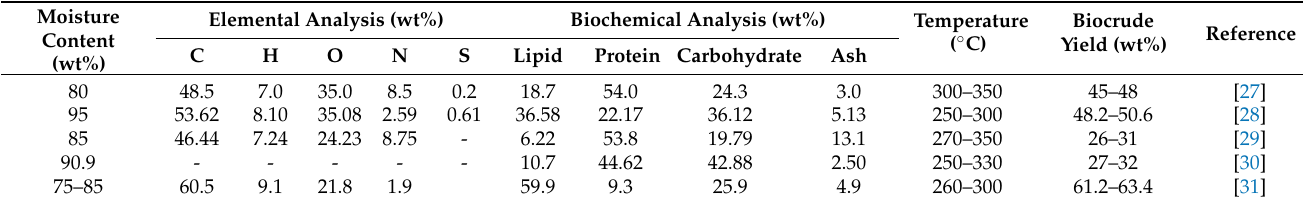
Table 2. Properties of Chlorella and experimental biocrude yields in literature